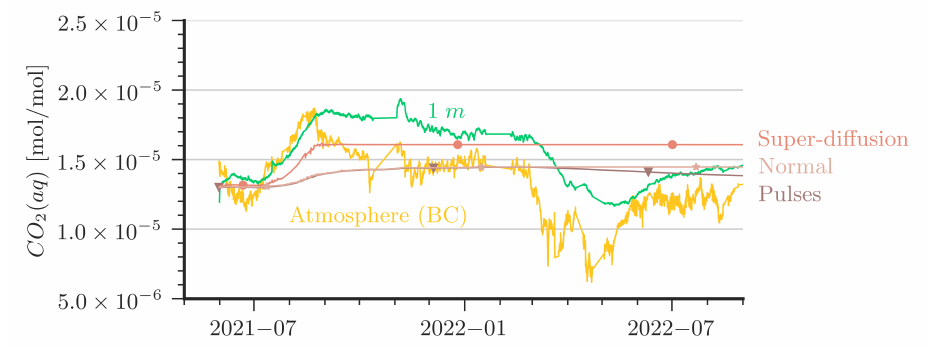
Figure 7. Comparison of aqueous CO 2 concentrations between measurement and simulations at 1 m depth. In addition, atmospheric CO 2 is plotted to show the driving force of the